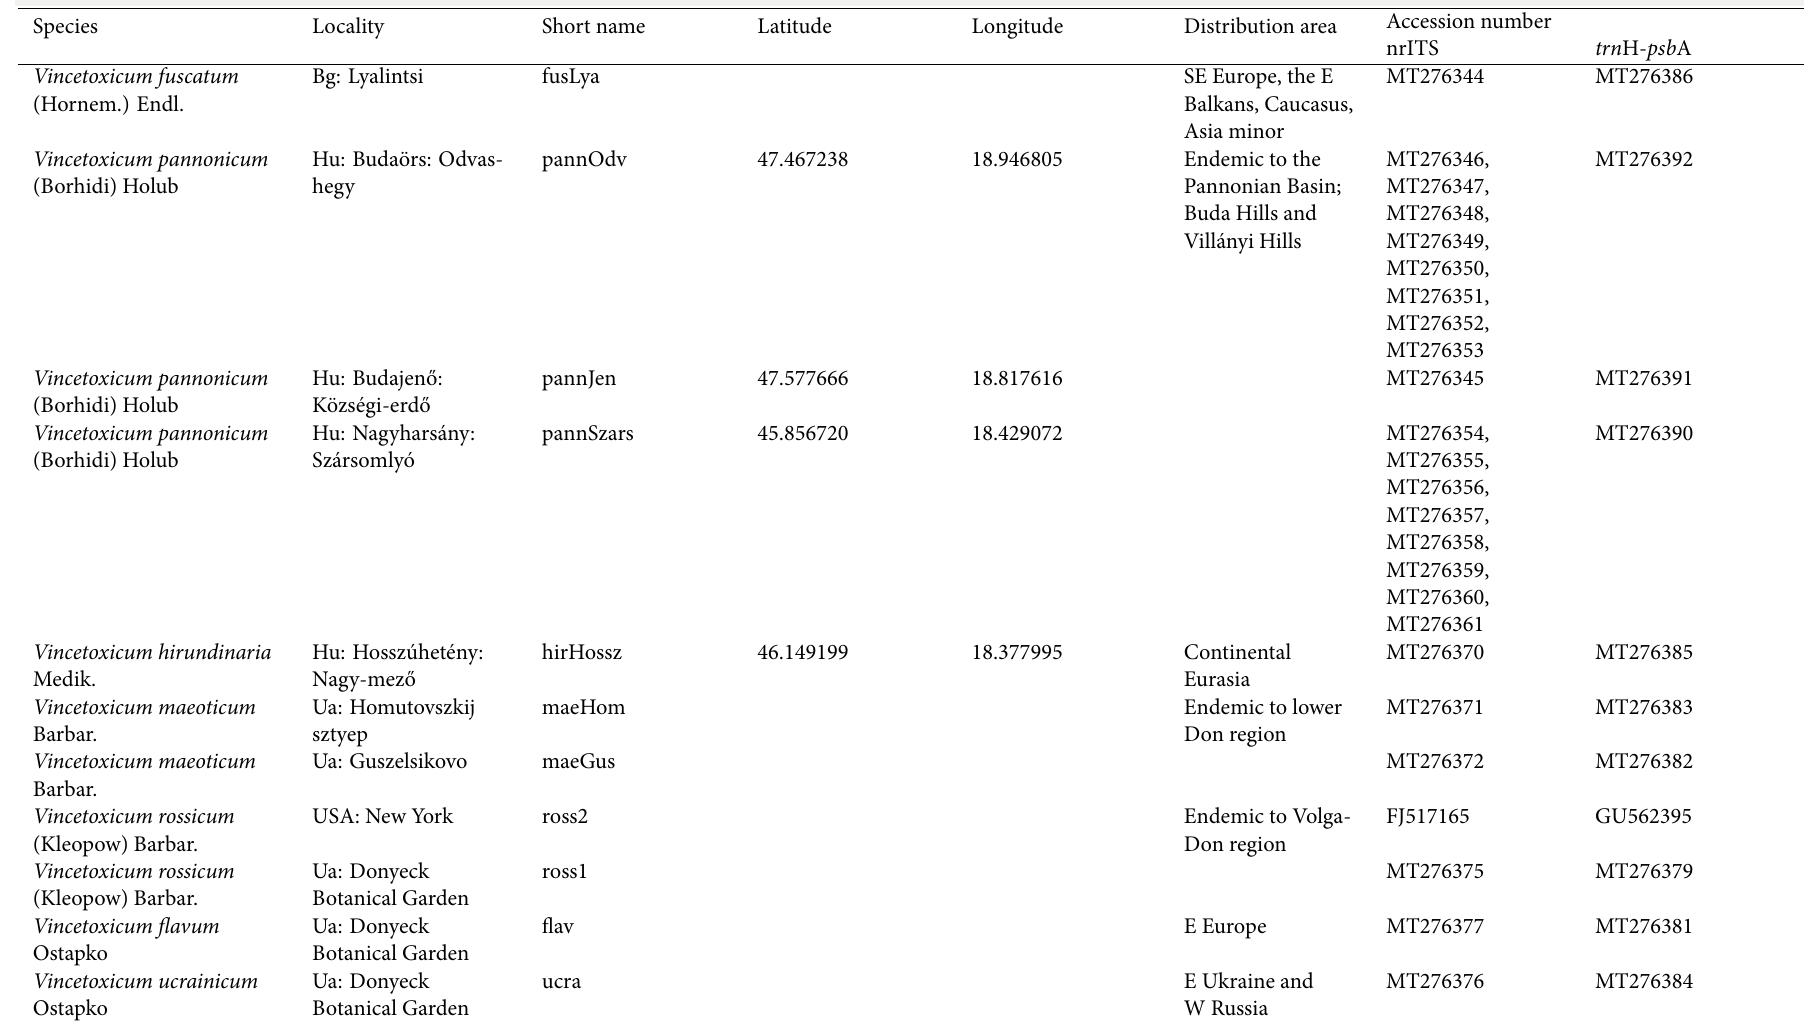
Table 1 List of samples analyzed inthe study with geographic locality and GenBank accession numbers. Short name refers to the sample code used in